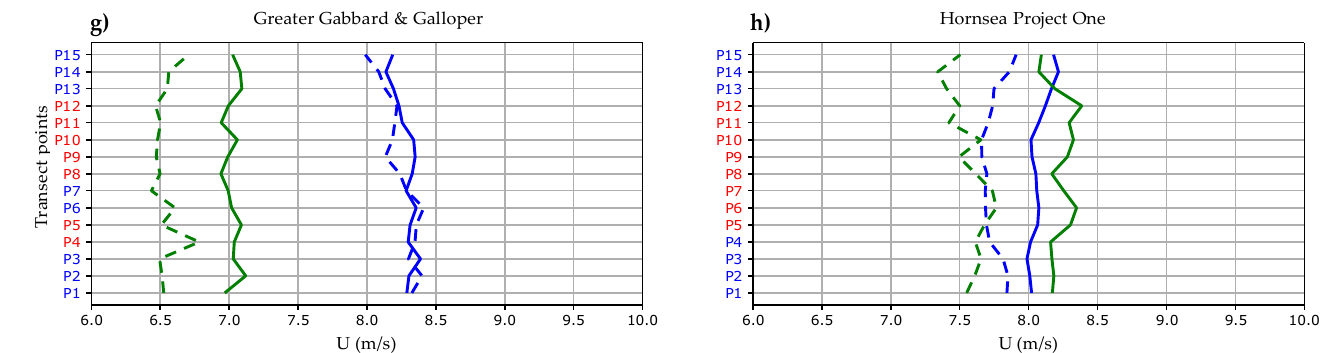
Figure 6. Mean wind speed ( U ) for easterly winds over the OWFs and clusters. See Figure 4 for the line definitions. ( a ) Anholt; ( b ) Horns Rev cluster; ( c ) Butendiek; ( d ) Nordsee cluster; ( e ) East Anglia One; ( f ) Global Tech cluster; ( g ) Greater Gabbard & Galloper; ( h ) Hornsea Project One. For the easterly wind sectors, we see reduced wind speeds downstream of Anholt, Butendiek, the Nordsee cluster and Greater Gabbard and Galloper, and Hornsea Project One (Figure 6a,c,d,g,h), which we assume to be caused by wind farm wake effects. The effect is less pronounced than for the westerly wind sectors. Once we calculate the velocity deficits, i.e., the difference between upstream and downstream wind speeds and account for the effect of HCWSGs, a clear pattern emerges, showing a velocity deficit for all OWFs and clusters, as illustrated in Figure 7. The deficit ranges from 2% at East Anglia One to almost 10% at Hornsea Project One, but it is also negative for some points along the transect lines (Figure 7b,d–f).